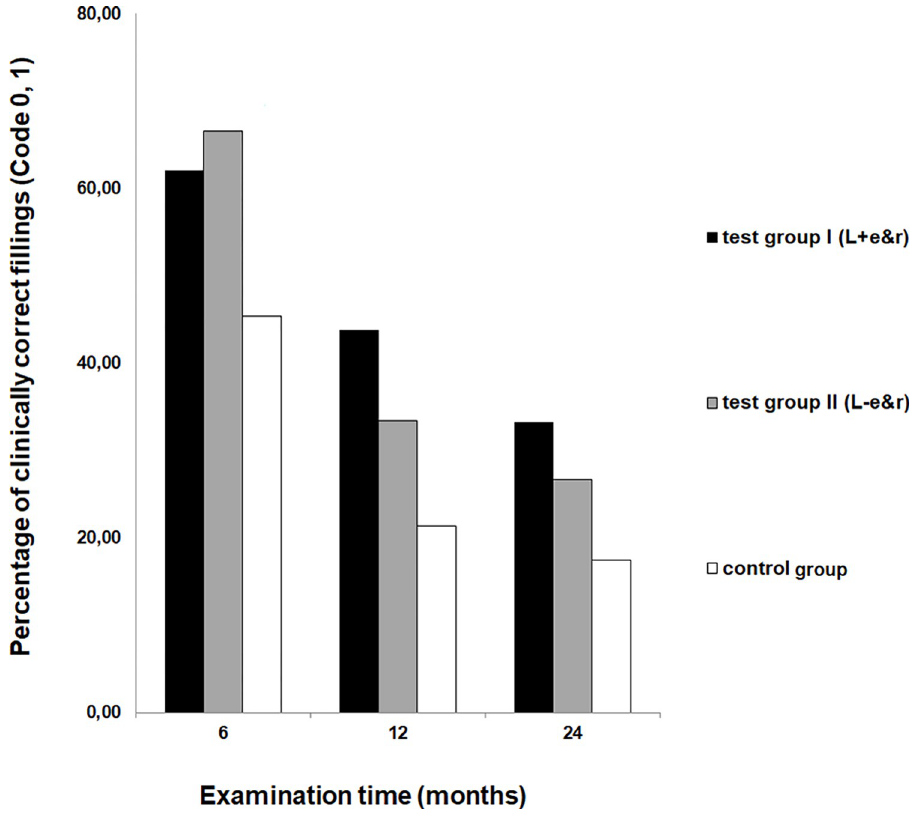
Fig 2. Clinical acceptance. The diagram shows the results assessed for the C-criteria “clinical acceptance” for all groups after 6, 12 and 24 months of wear.